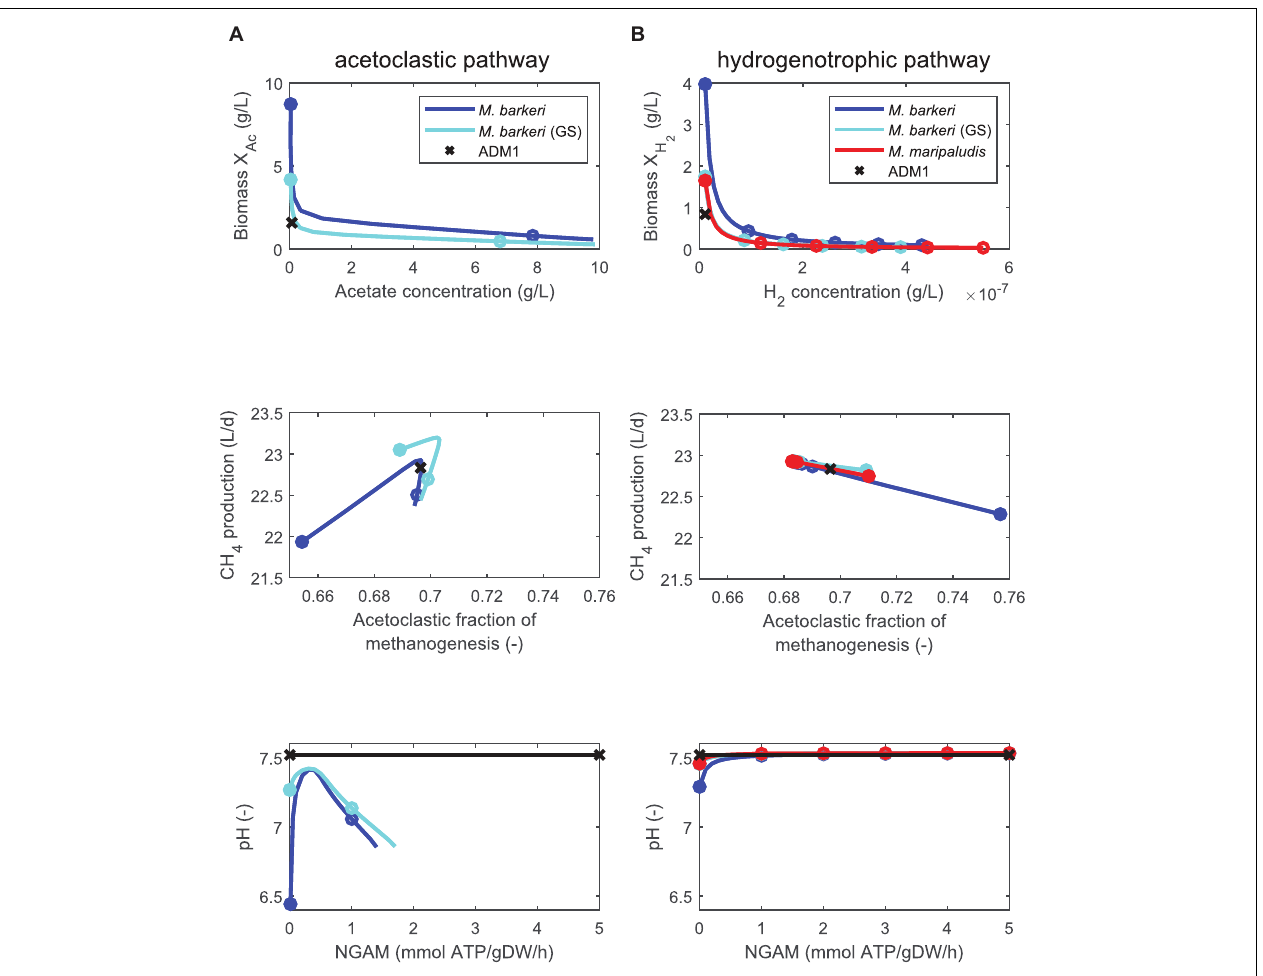
FIGURE 3 | Comparing steady-state model predictions of standard ADM1 (x) and coupled models in which the non-growth associated maintenance (NGAM) demand is varied between 0 (closed symbols) and 5 mmol ATP/gDW/h (open symbols mark increments of 1), using continuously fed maize silage as substrate. Two pathways contribute to methanogenesis: (A) Only the acetoclastic pathway is replaced by FBA models of M. barkeri, either by a minimal or a genome-scale model (GS). (B) Only the hydrogenotrophic pathway is replaced by FBA models of M. barkeri [same variants as for (A) ] or M. maripaludis